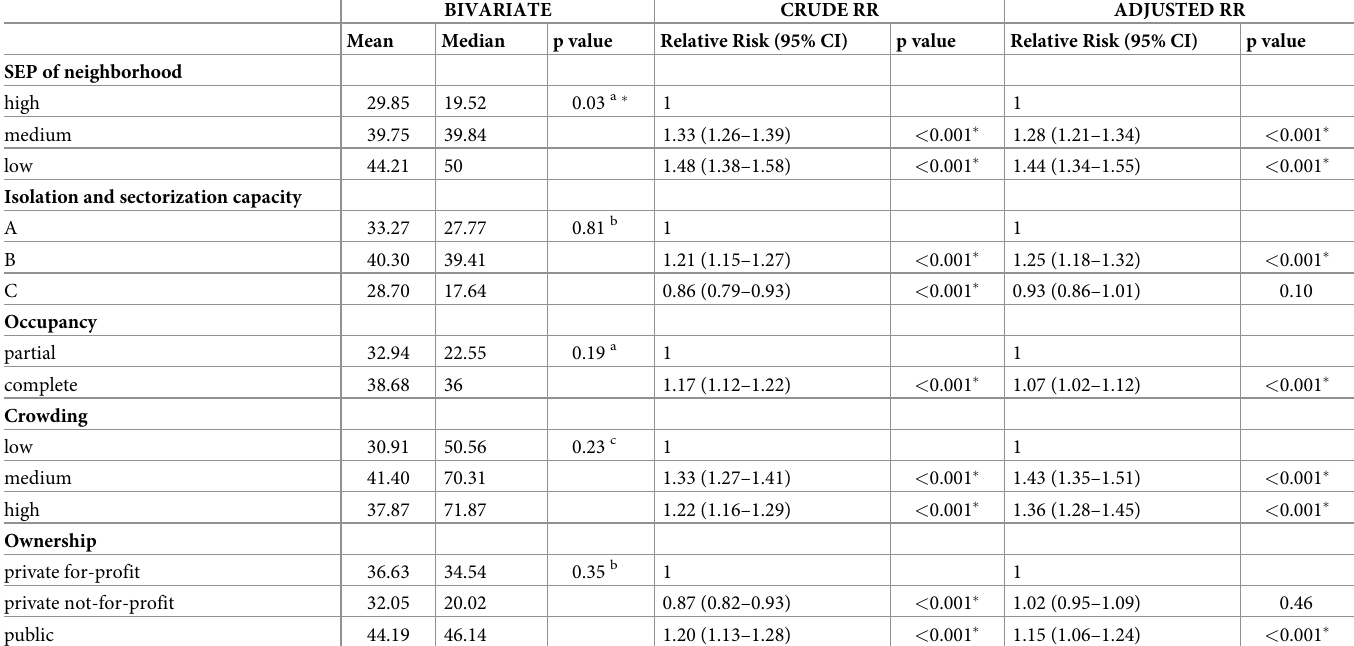
Table 1. Cumulative incidence by COVID-19 of the nursing homes by socioeconomic and structural variables of the NHs in the period from March to June 2020 in Barcelona.